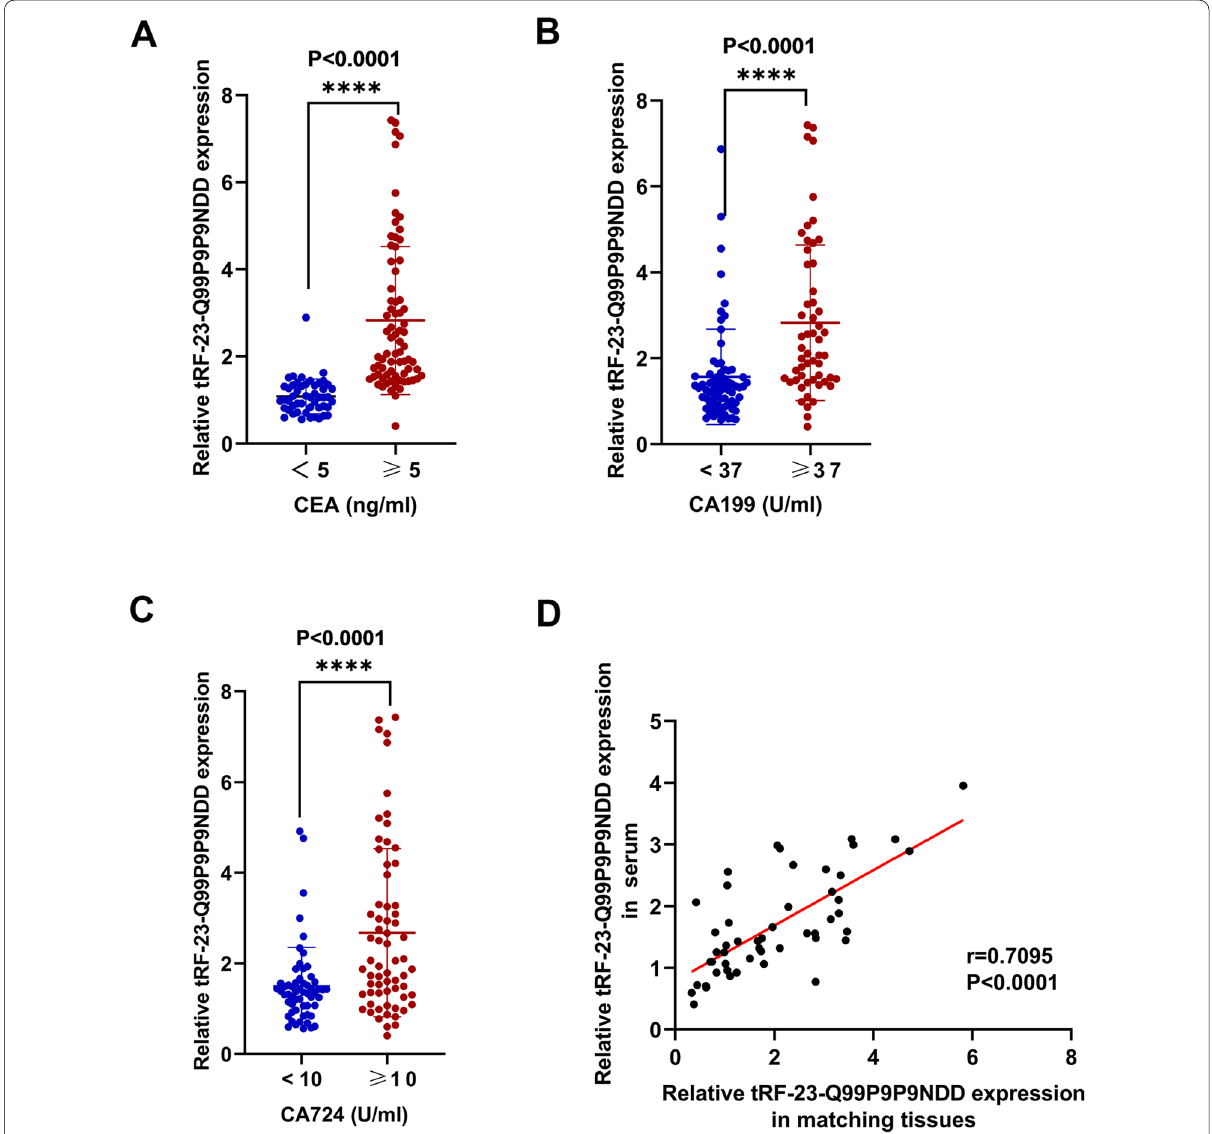
Fig. 4 The relationship between the expression levels of serum tRF-23-Q99P9P9NDD and conventional biomarkers of GC. A–C GC patients were divided into two groups according to the diagnostic thresholds of CEA, CA199, and CA724, and the expression level of tRF-23-Q99P9P9NDD was analyzed respectively. D Pearson correlation analysis was performed on tRF-23-Q99P9P9NDD expression levels in 50 GC tissues and serum samples from corresponding patients. *P < 0.05; **P < 0.01; ***P < 0.001; ****P <